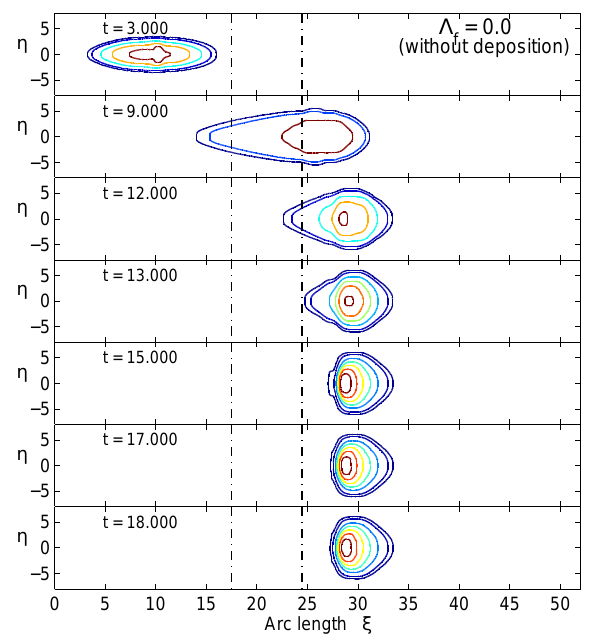
Fig. 2. Contour plots of the flowing mass down the inclined flat plane onto the horizontal area, where the material is assumed to be dry ( Λ f = 0 ), without adopting the deposition procedure.